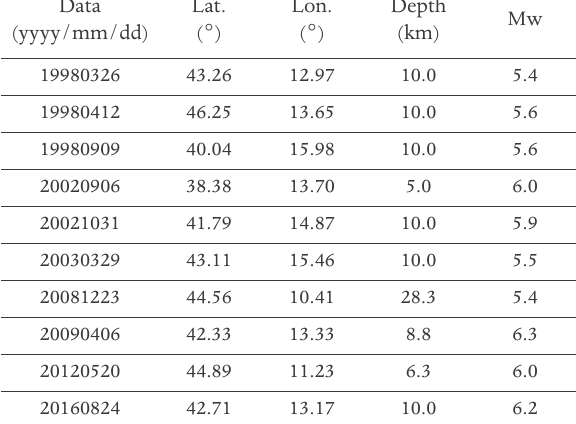
Table 2. Event list extracted by the NEIC website (National Earth- quake Information Center; http://earthquake.usgs.gov/earth quakes/search/) for earthquakes occurred in Italy since 1/1/1998 to 28/8/2016 and related parameters.